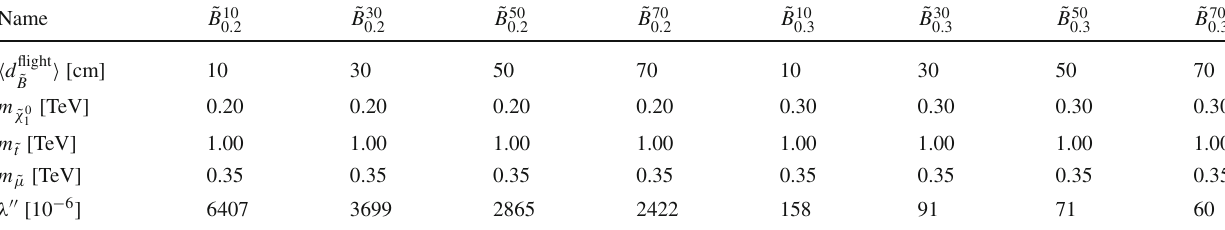
Table 2 Definition of the eight benchmarks for the direct neutralino production pp → ˜ χ 0